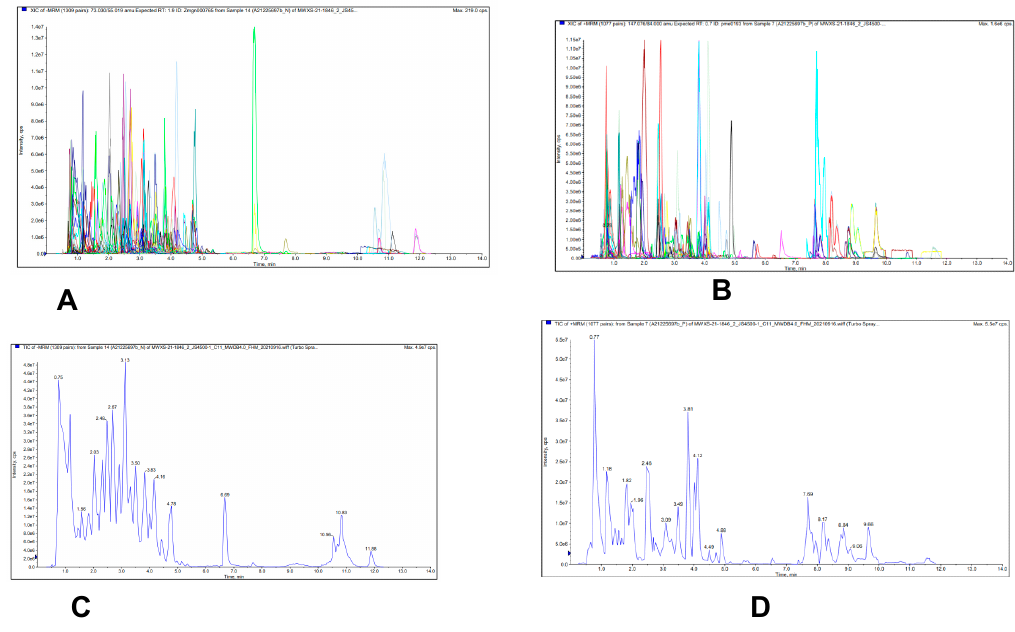
Figure 1. ( A , C ) Multiple reaction monitoring (MRM) and total ions current (TIC) and metabolite detection of negative ion mode; ( B , D ) MRM and TIC metabolite detection of positive ion mode multipeak mass spectral chromatogram of metabolites of fresh amla fruit.